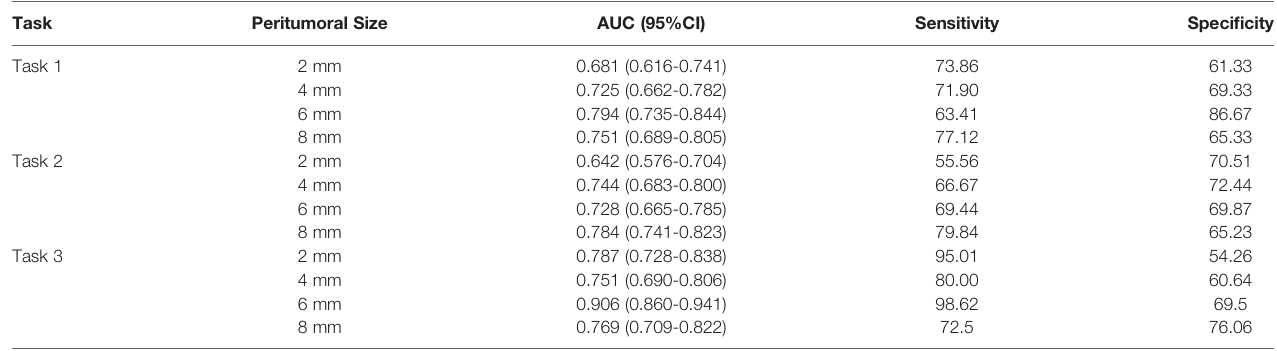
TABLE 2 | Performance of peritumoral models in tasks 1 – 3. Task